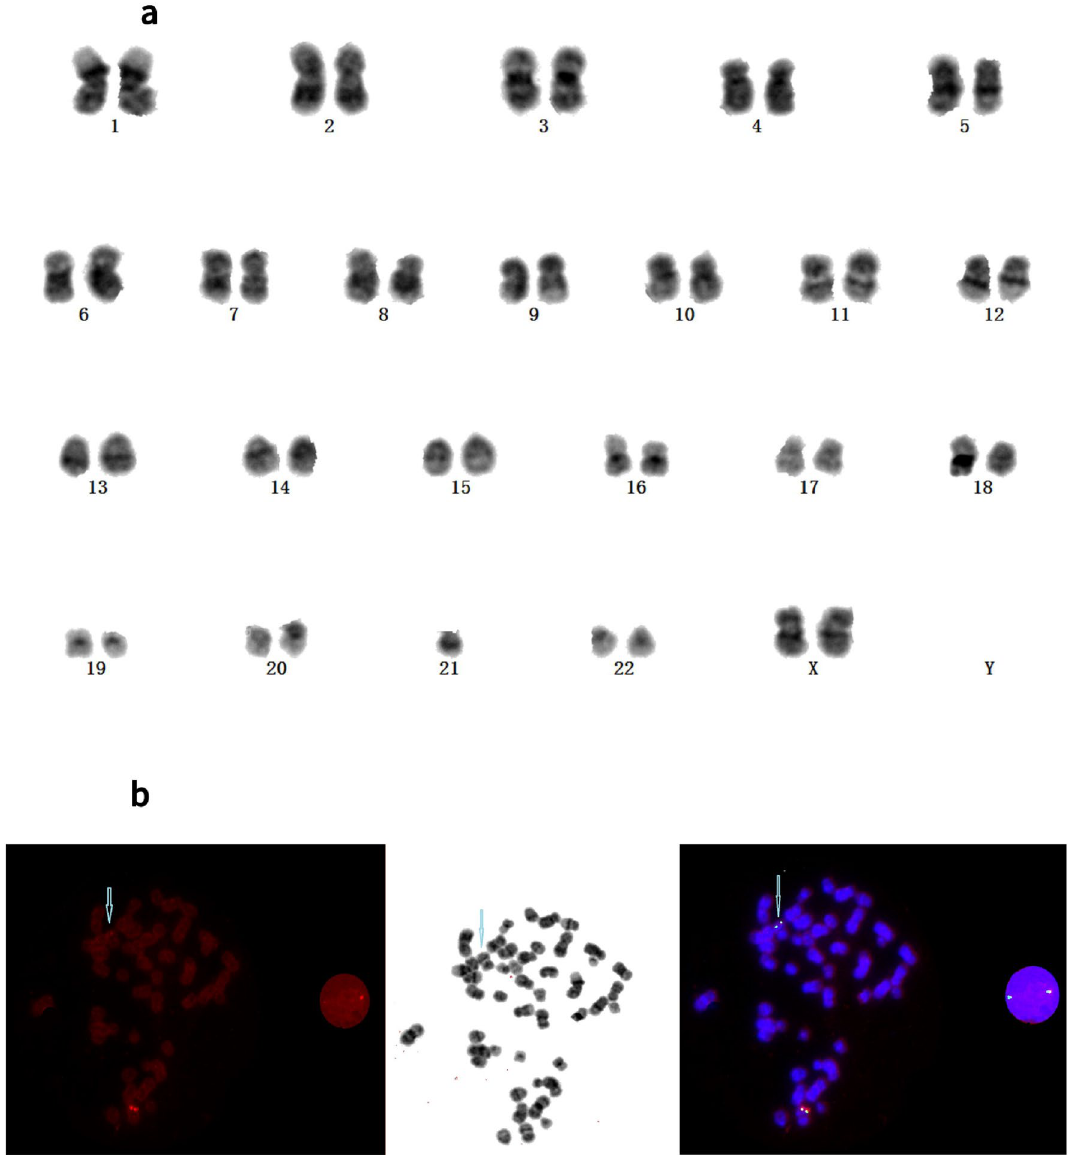
Figure 3. ( a ) Karyotype of Patient 3 showing 46,XX. ( b ) Fluorescence in situ hybridization (FISH) analysis of a metaphase cell of Patient 3 using the KMT2A probe. Two intact KMT2A copies were revealed, and one of the two KMT2A fusion signals (3 ′ - KMT2A orange signal) was significantly diminished (blue